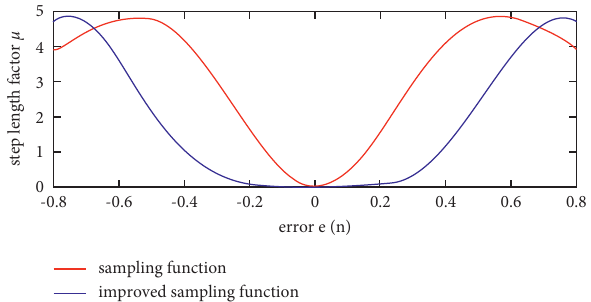
Figure 8: Comparison diagram of sample function curve and improved sample function curve.